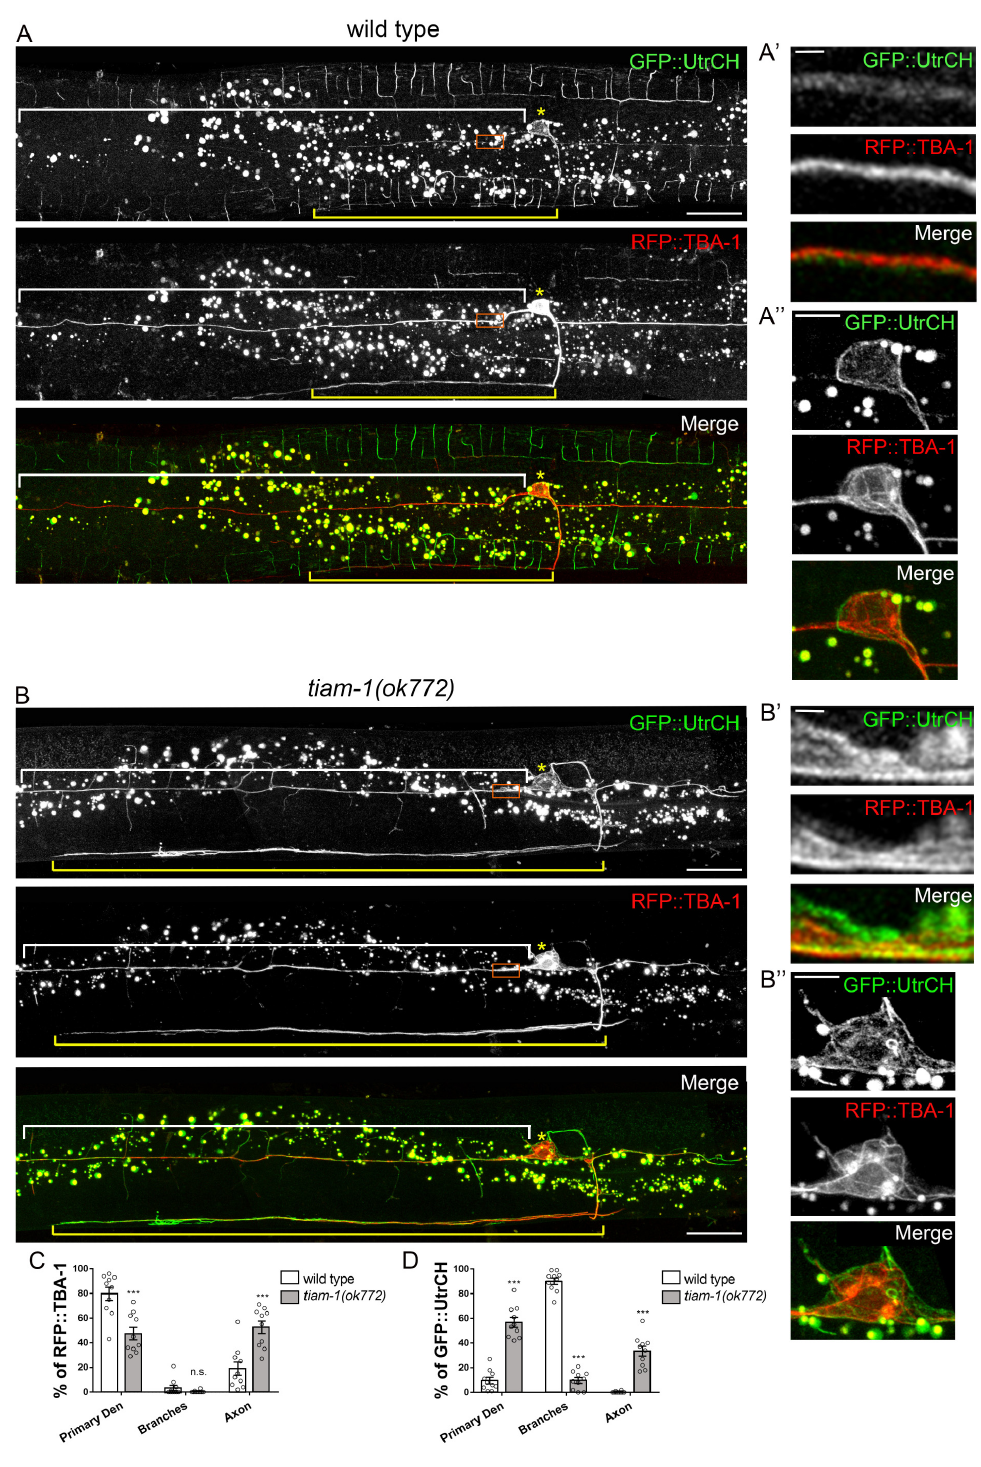
Fig 5. TIAM-1 is required for the proper organization of MTs and actin filaments. (A and B) PVD neurons expressing F-actin marker GFP::UtrCH and MT marker RFP::TBA-1 in wild type (A) and tiam-1(ok772) (B). In wild-type PVD, F-actin was mainly distributed in high-order dendritic branches, while MT was mainly distributed in the primary dendrites (white brackets) and the axon (yellow brackets). In tiam-1(ok772) , F-actin and MT were abnormally distributed in the